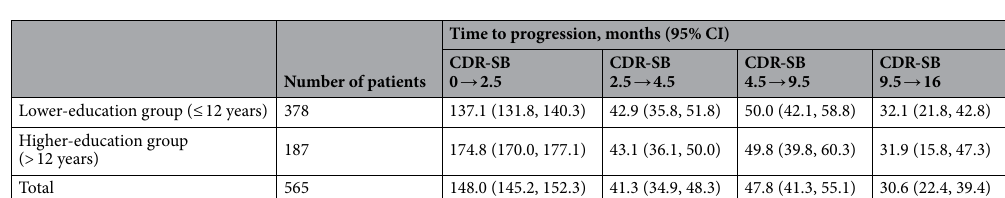
Table 3. Time to CDR-SB increase according to level of education. CDR-SB: clinical dementia rating sum of boxes.